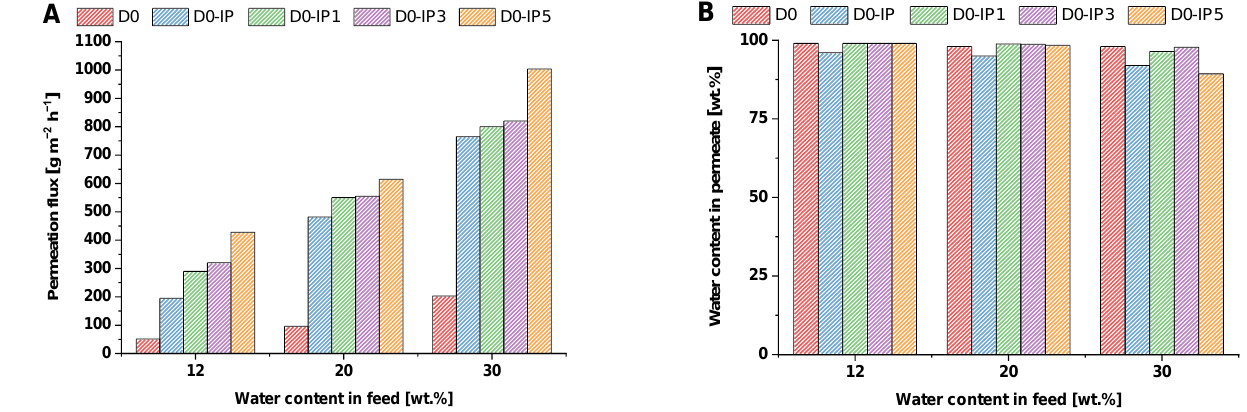
Figure 8. Pervaporation performance of the TFC and TFN membranes with the ChS interlayer. ( A ): permeation flux; ( B ): water content in the